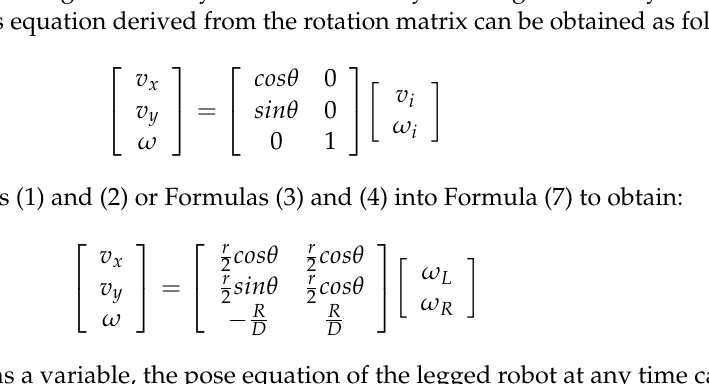
Figure 5. Kinematics model.